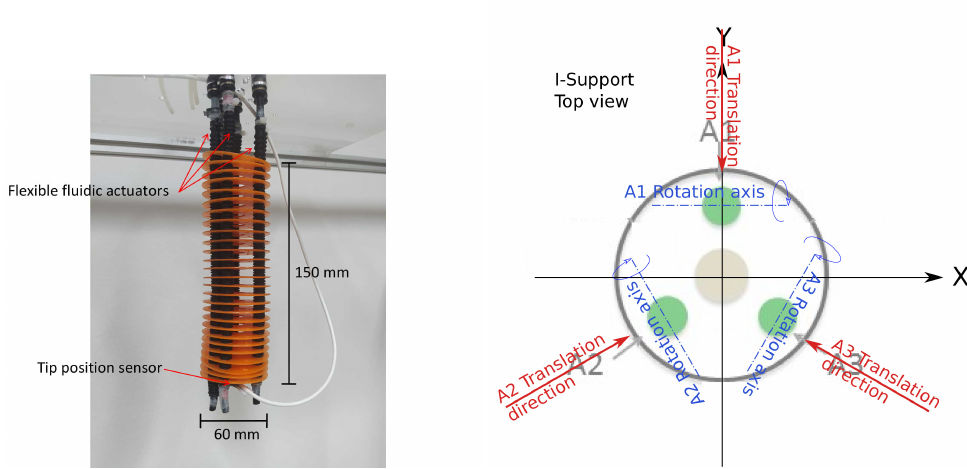
Figure 1. I-Support kinematic